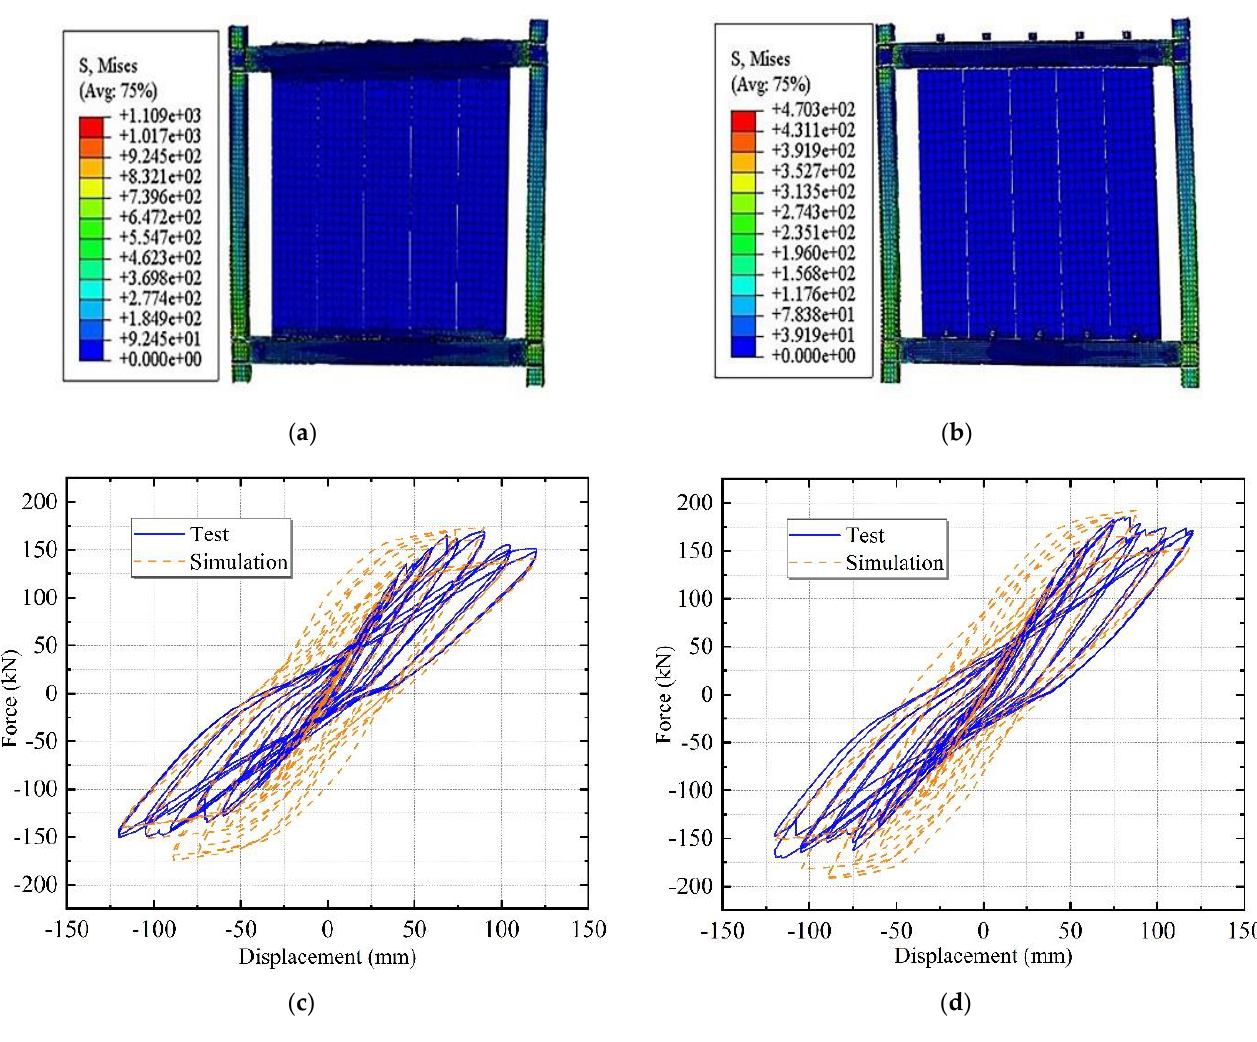
Figure 15. Comparing the stress cloud diagrams of the specimens and hysteresis curves of the test and simulation. ( a ) FEM1; ( b ) FEM2; ( c ) L-hooked bolt; ( d ) Slip-type crossing connector.